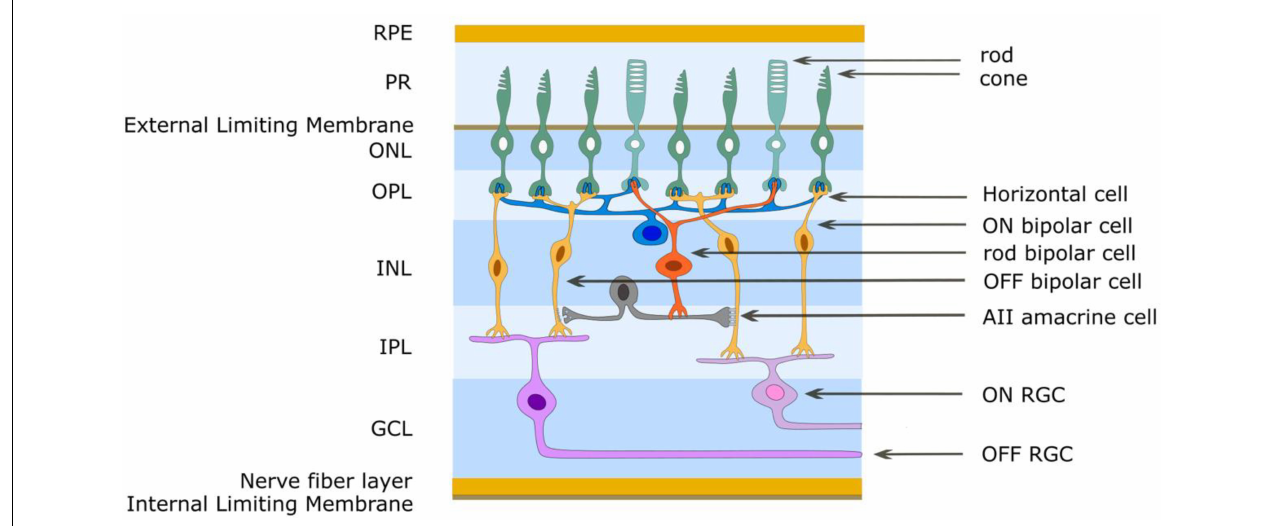
FIGURE 3 | Simplified schematic diagram of the OFF and ON retinal pathways. Glutamate is released from photoreceptor terminals in darkness in the outer plexiform layer and generates the OFF pathway by exciting OFF bipolar cells through ionotropic glutamate receptors. Glutamate acts on mGluR6 receptors of ON bipolar cells to create sign-inverting inhibitory responses, thus creating the ON pathway. Light reduces glutamate release from photoreceptors. The AII amacrine cell acts to create the OFF and ON pathways for rod-driven (scotopic) vision. The rod bipolar cell has mGluR6 receptors and gives an ON response to light. It also uses glutamate as its neurotransmitter and through ionotropic glutamate receptors depolarizes AII amacrine cells. This cell provides differential output to cone bipolar cells in the inner plexiform layer. ON cone bipolar cells are connected to the AII amacrine cell through gap junctions (excitatory) while OFF cone bipolar cells are connected to the AII amacrine cell by glycinergic (inhibitory) chemical synapses. RPE retinal pigment epithelium, PR photoreceptor outer segments, ONL outer nuclear layer, OPL outer plexiform layer, INL inner nuclear layer, IPL inner plexiform layer, GCL ganglion cell